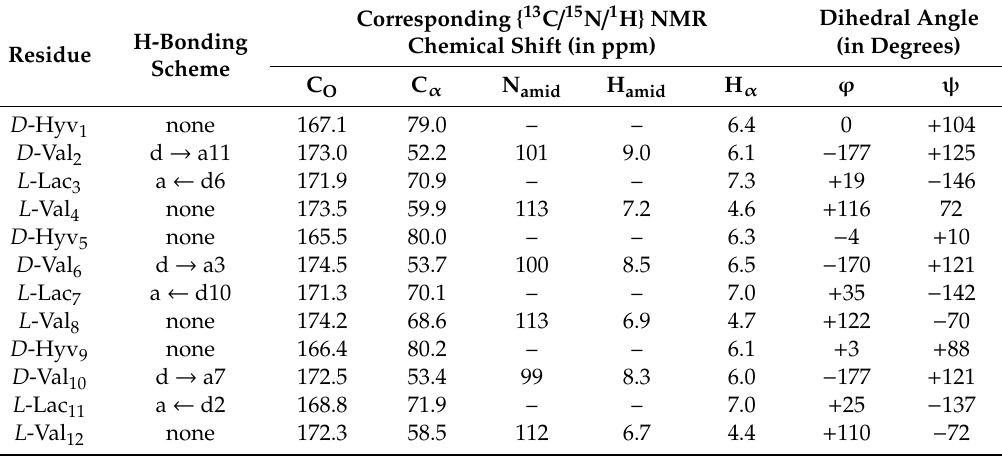
Table 4. The PW PBE structural and spectral parameters of the “propeller” crystalline phase of